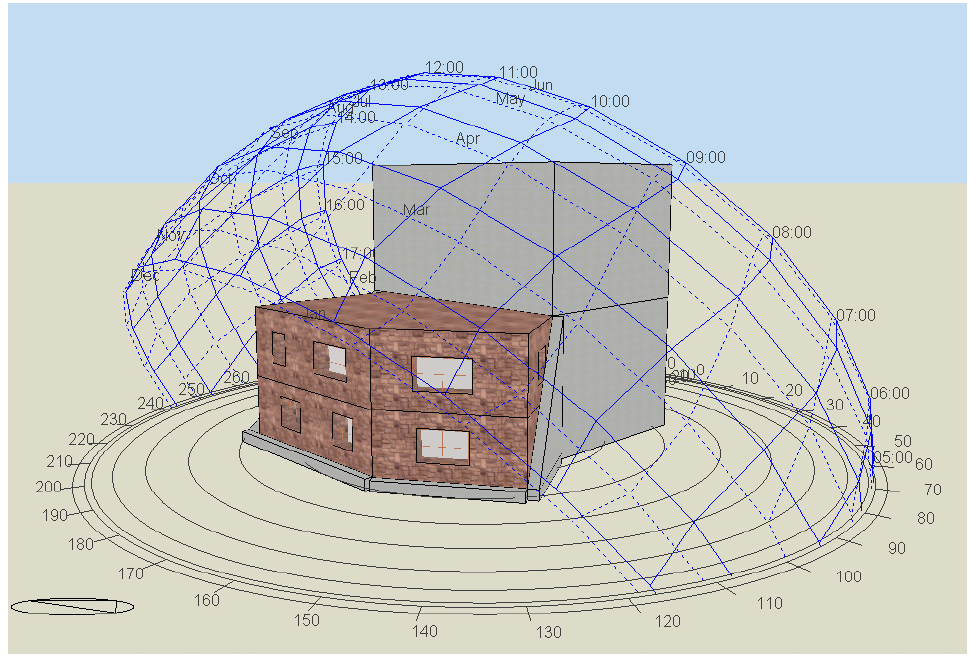
Figure 2. The building 3D model.